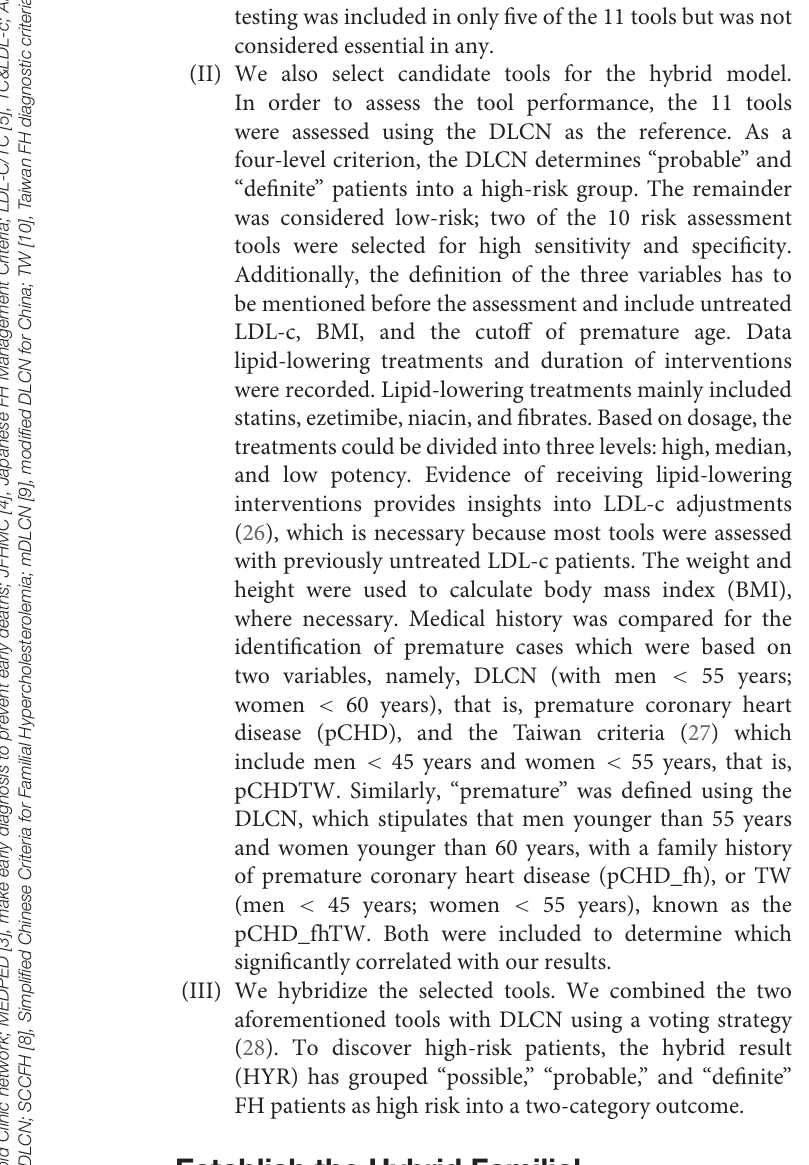
Supplementary Material Table 1 . Lipid levels and physical examination are the two most common factors.